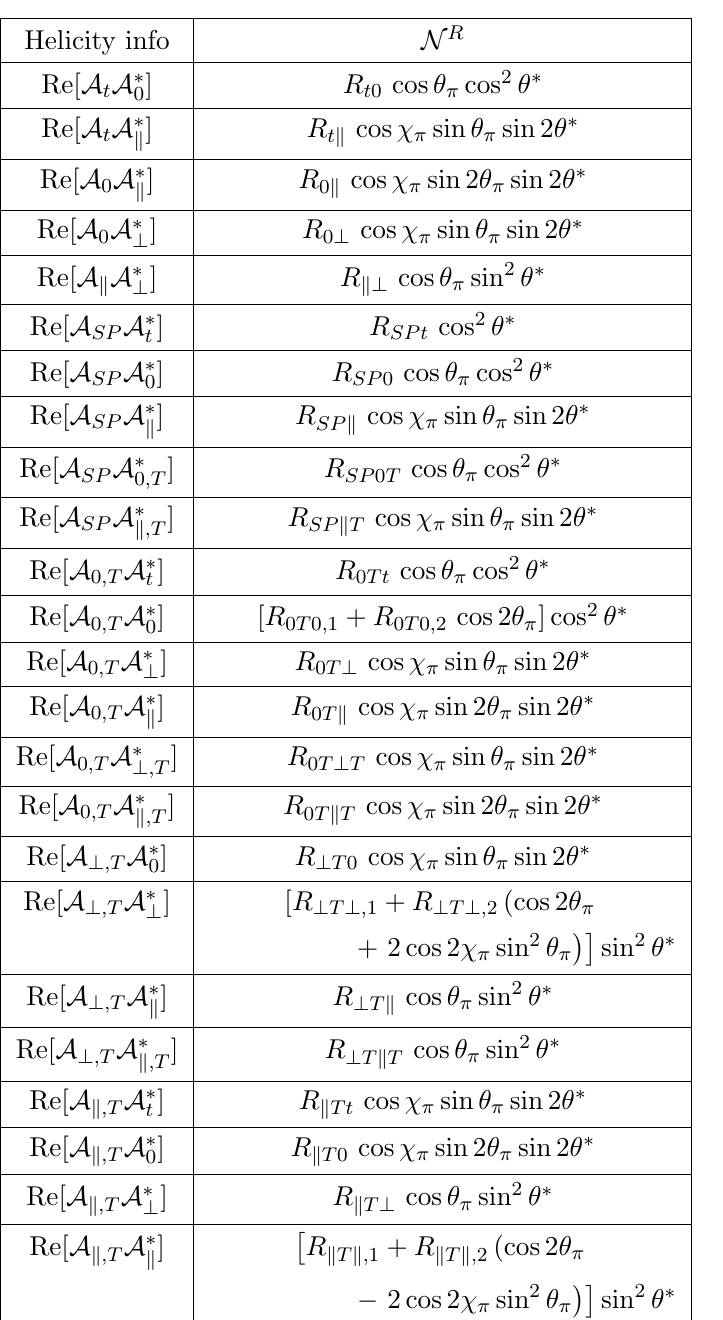
Table 6 . Contributions to the N R the kinematic parameters q 2 and E (cid:25) , and are listed in eq.